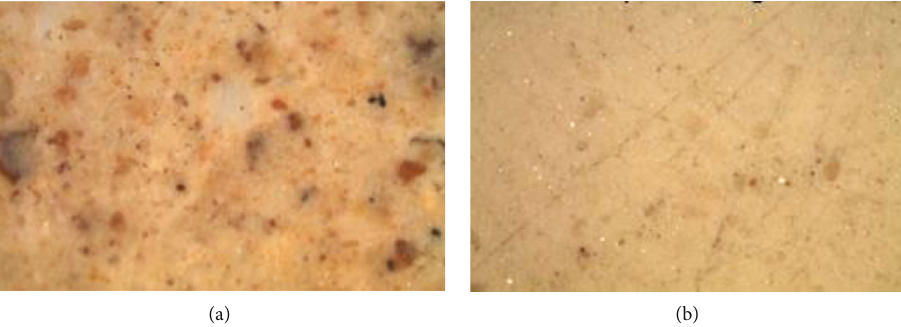
Figure 3: The optical images of (a) raw kaolin and (b) MK clay after heat treatment at 600 ° C.